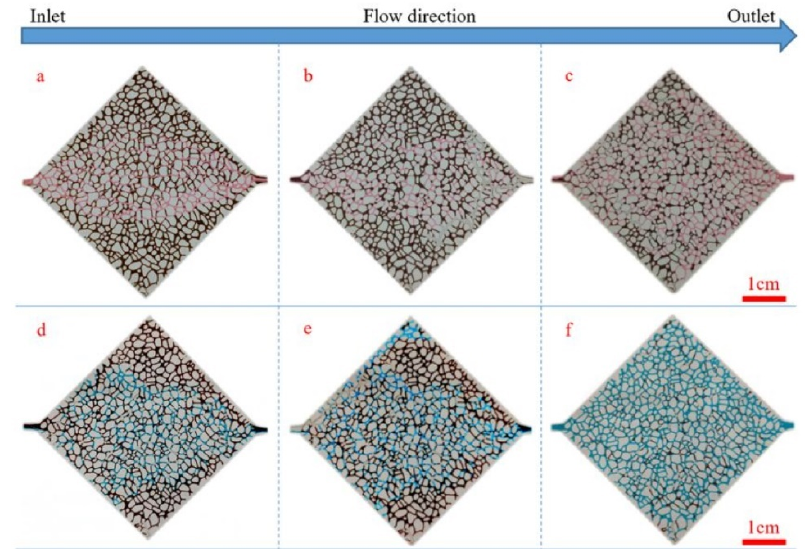
Figure 8. Comparison of the oil recovery effects between water flooding and magnetic graphene oxide fluid flooding in the microscopic model: ( a ) after water flooding, ( b ) microwave treatment for 5 min after water flooding, ( c ) subsequent displacement, ( d ) after MGO fluid flooding, ( e ) microwave treatment for 5 min after MGO fluid flooding, and ( f ) subsequent displacement. (Reproduced with permission from [139]. ACS Publications, 2019).